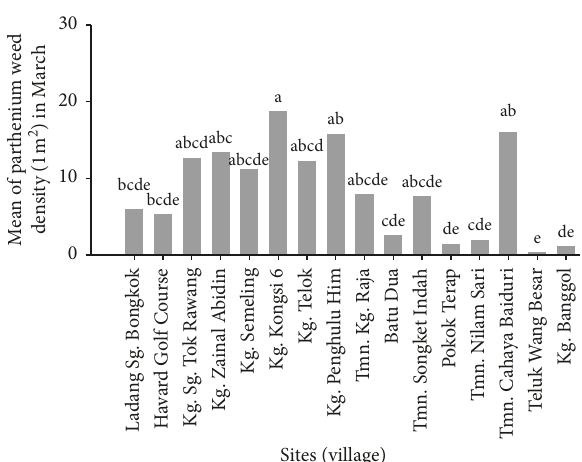
Figure 7: Percent coverage by parthenium weed in different vil- lages of Kuala Muda in March 2015. Kg. � Kampung, Tmn. � Taman, and Sg. � Sungai. Dissimilar small letters on bars indicate a significant difference.